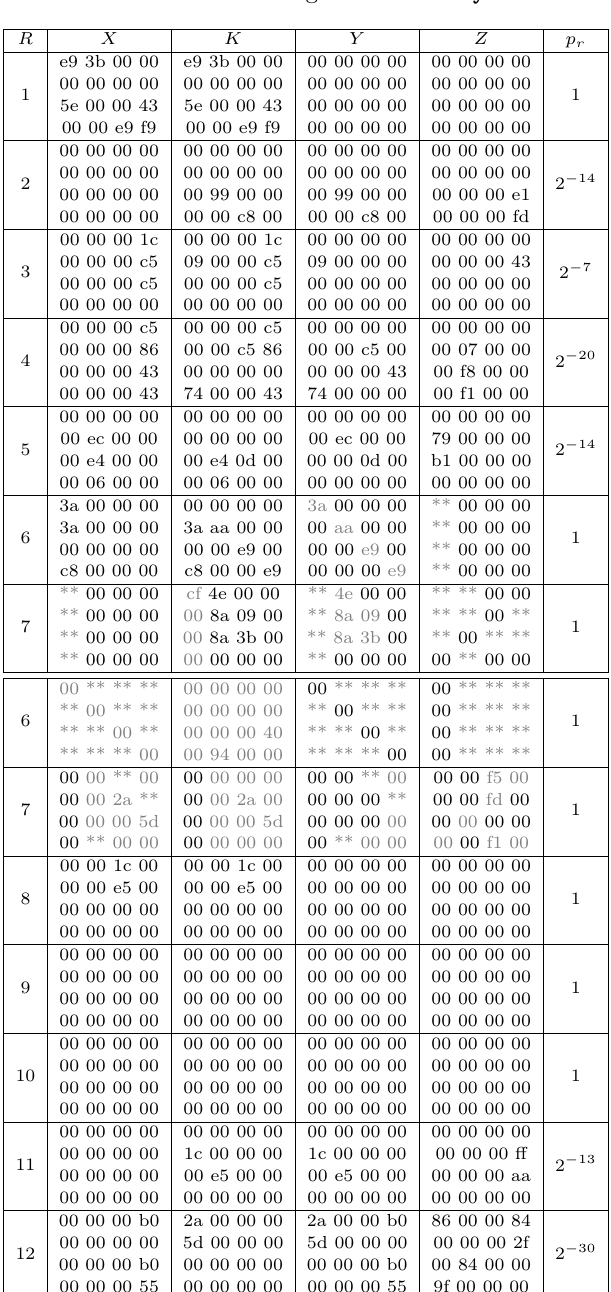
Table 13: 12-round distinguisher of